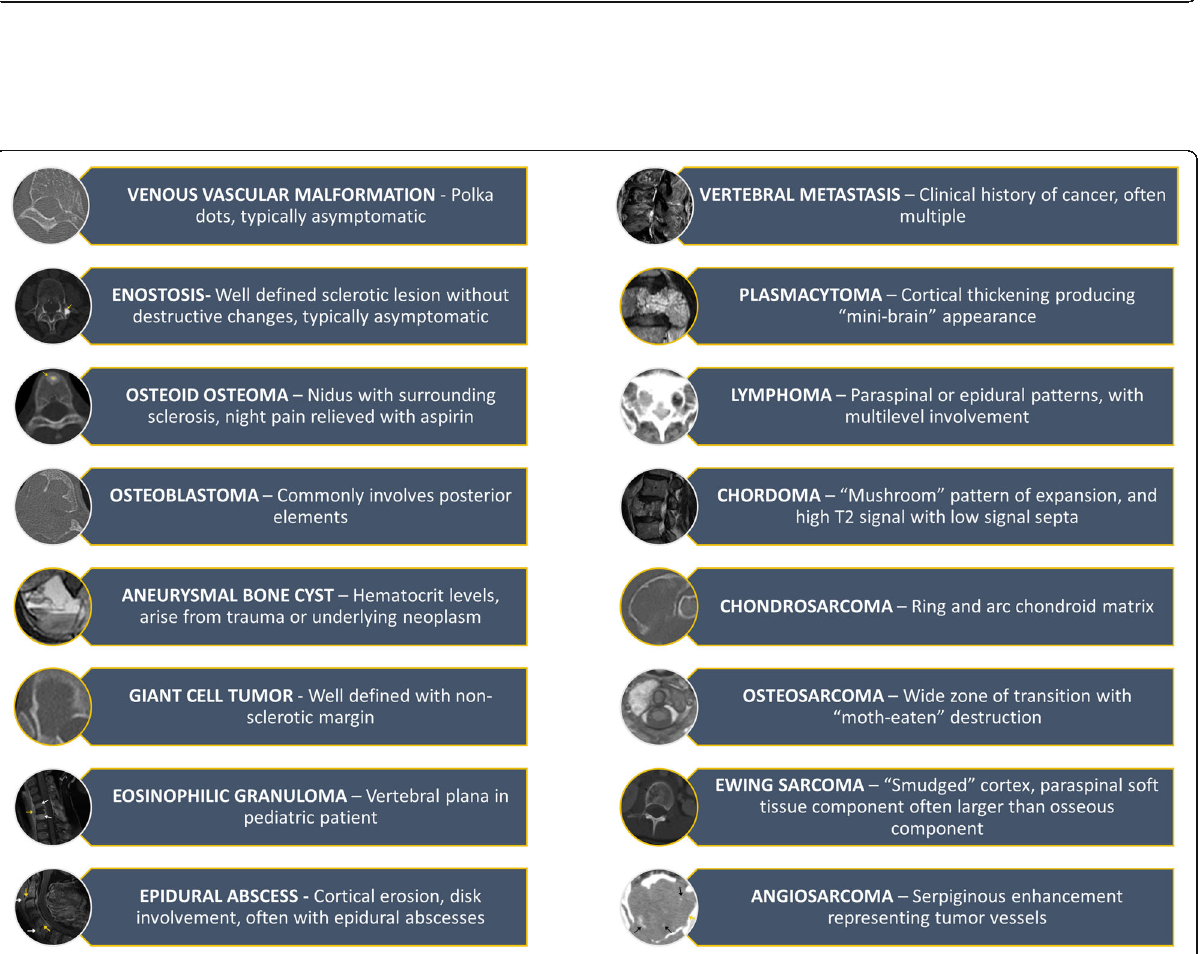
Fig. 22 Summary of the lesions discussed in this article with their characteristic imaging and clinical